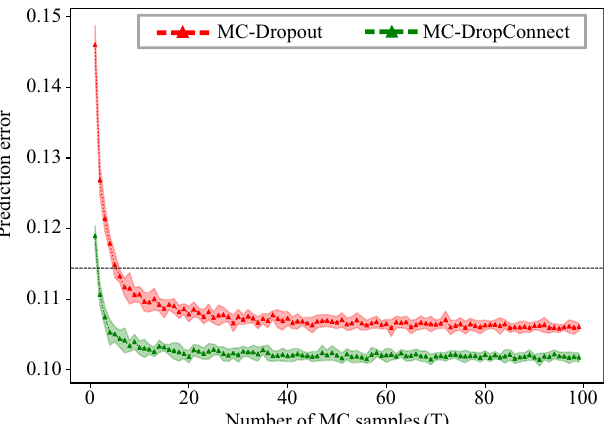
Figure 6. Test error of the FCNet on CIFAR-10 for different numbers of forward-passes in MC-Dropout and MC-DropConnect, averaged with 10 repetitions. The shaded area around each curve shows one standard deviation. The black dotted line shows the test error for the same neural network with no